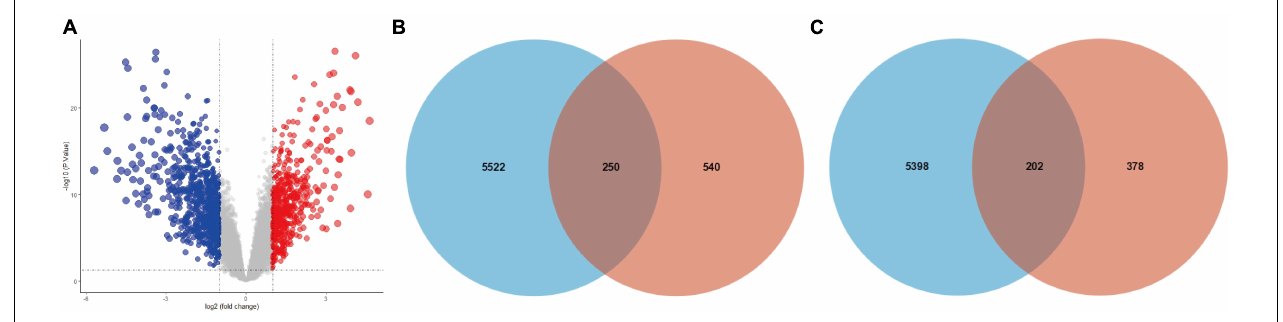
FIGURE 3 | Intersection of target genes of hub miRNAs and corresponding DE-mRNAs. (A) DE-mRNAs between HB and normal liver samples in the GSE131329 dataset were visualized using volcano plot. Red points representing up-regulation; blue points indicating down-regulation; gray points representing normal expression. The intersection of target genes of (B) upregulated or (C) downregulated hub miRNAs and corresponding DE-mRNAs. DE-mRNAs, differentially expressed